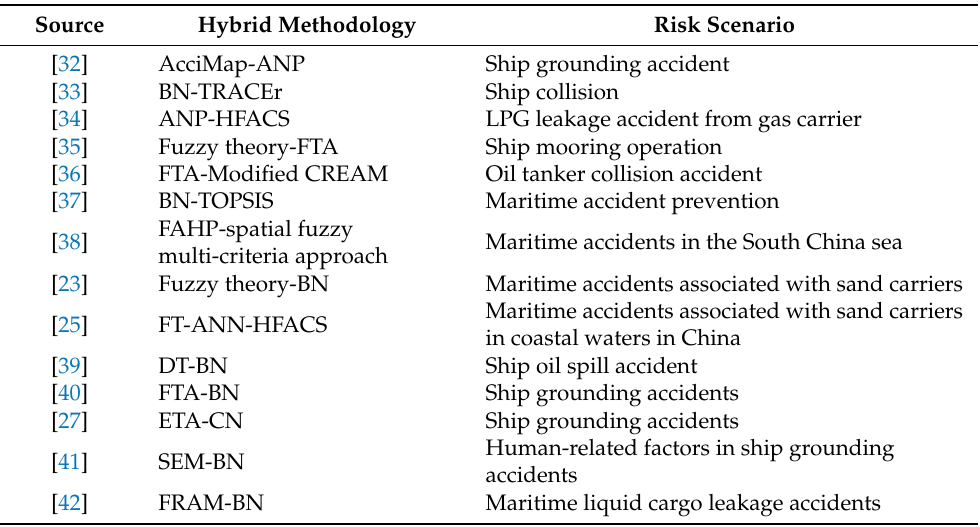
Table 1. Hybrid methodologies used within the scope of marine accident analysis in recent years. Source Hybrid Methodology Risk